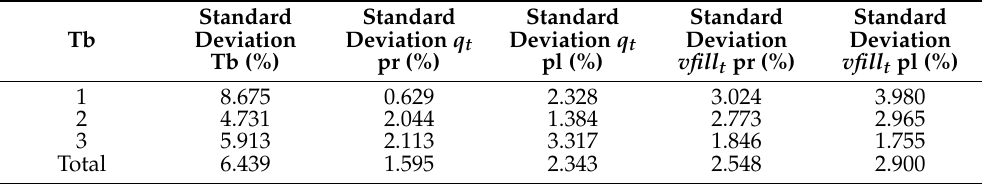
Table 8. Standard deviation in the results of the brake type, q t and vfill t simulations of pressure sensors. Standard Standard Tb Deviation Deviation q t Tb (%) pr (%)